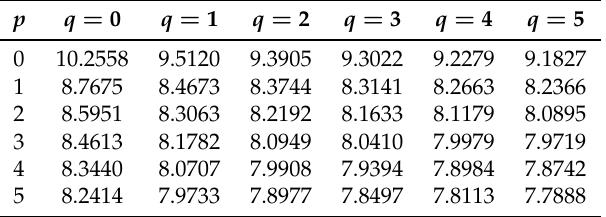
Table A1. Conditional entropies H ( p , q ) (bits/pixels), computed for various values of p and q , over “Levada”.